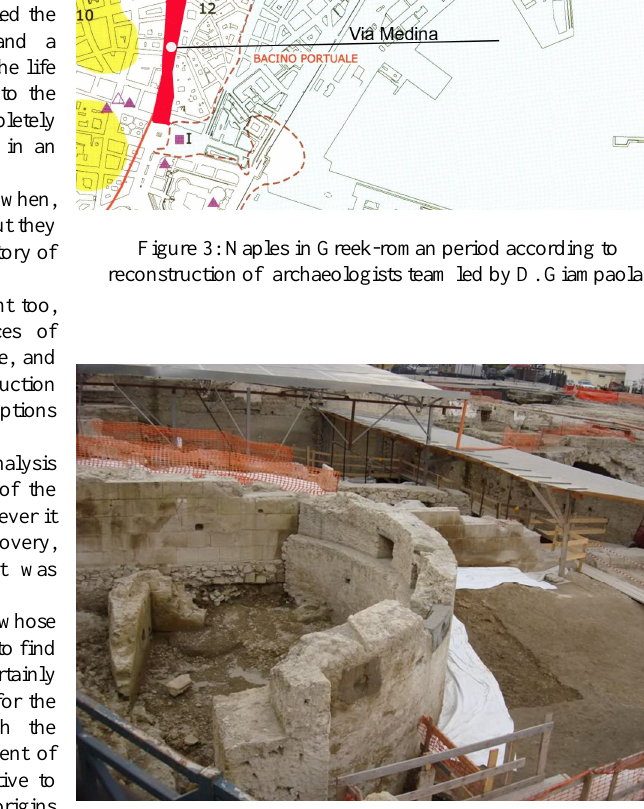
Figure 4: finds from Angevin period